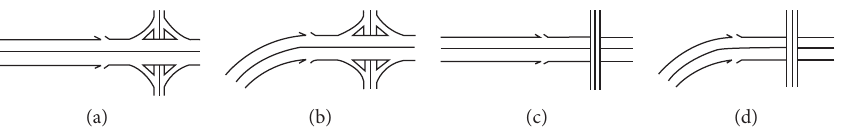
Figure 1: Collection point situation.